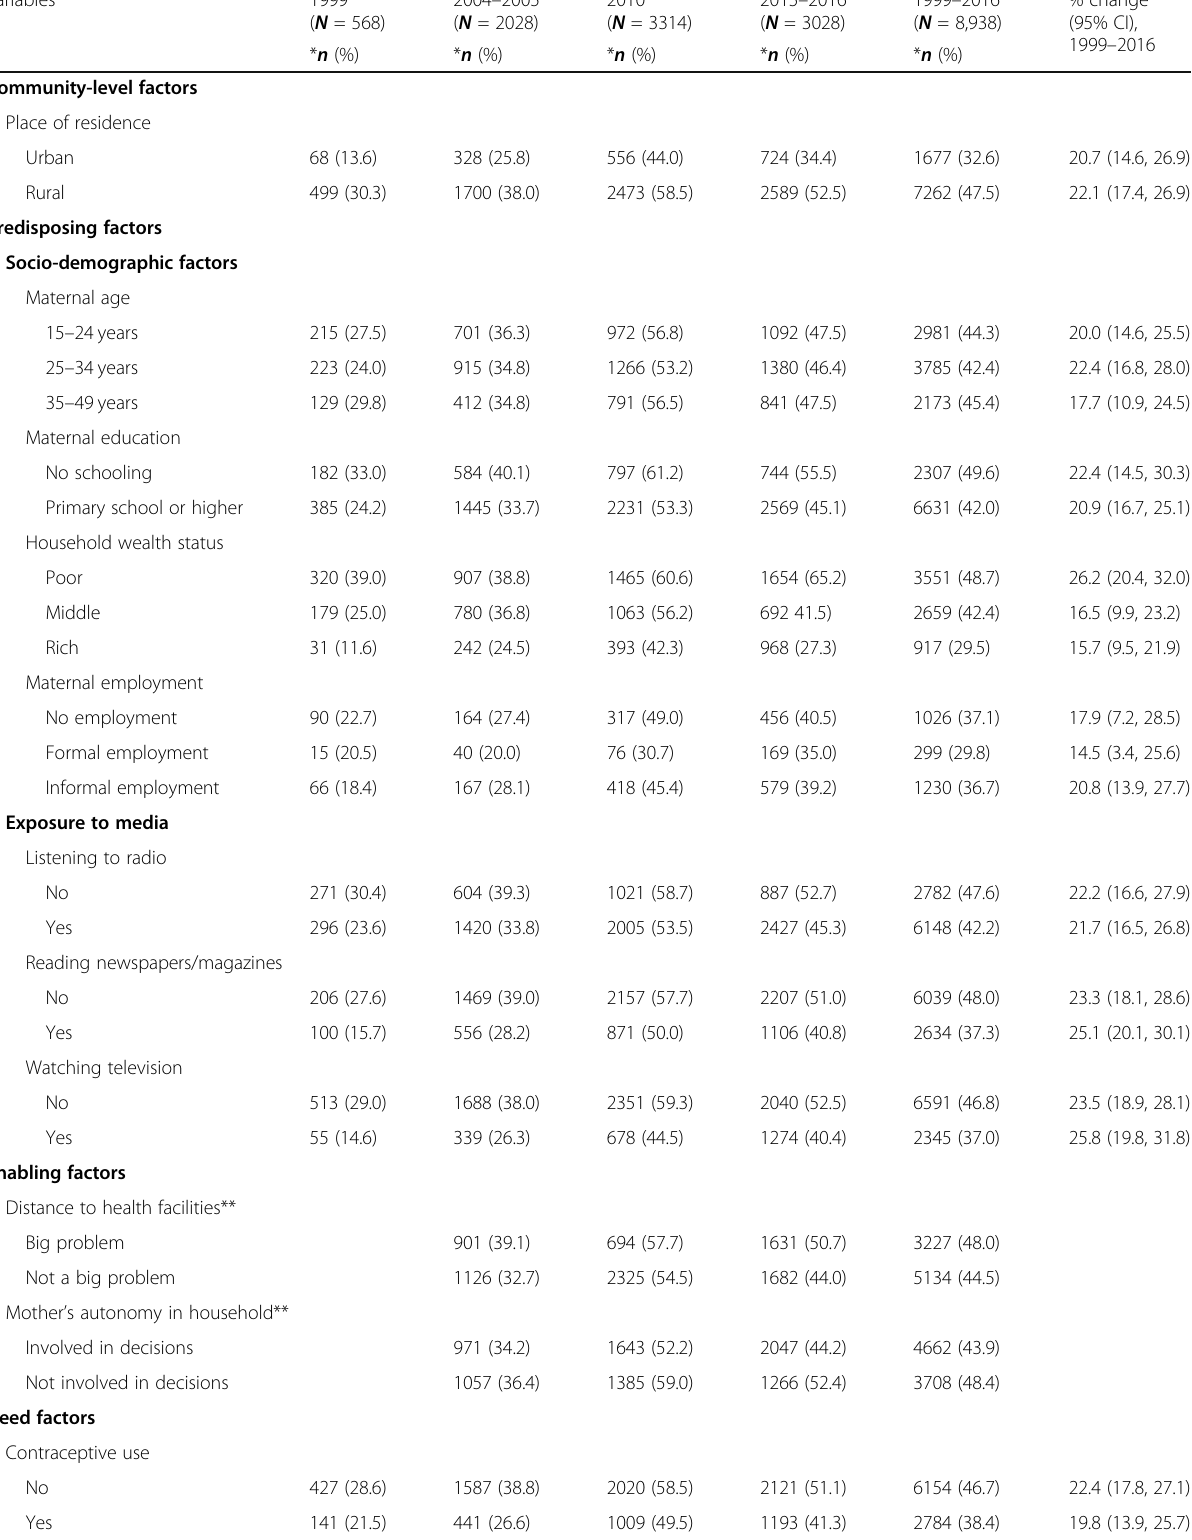
Table 2 Prevalence of one to three antenatal care visits by the study factors in Tanzania, 1999 – 2016